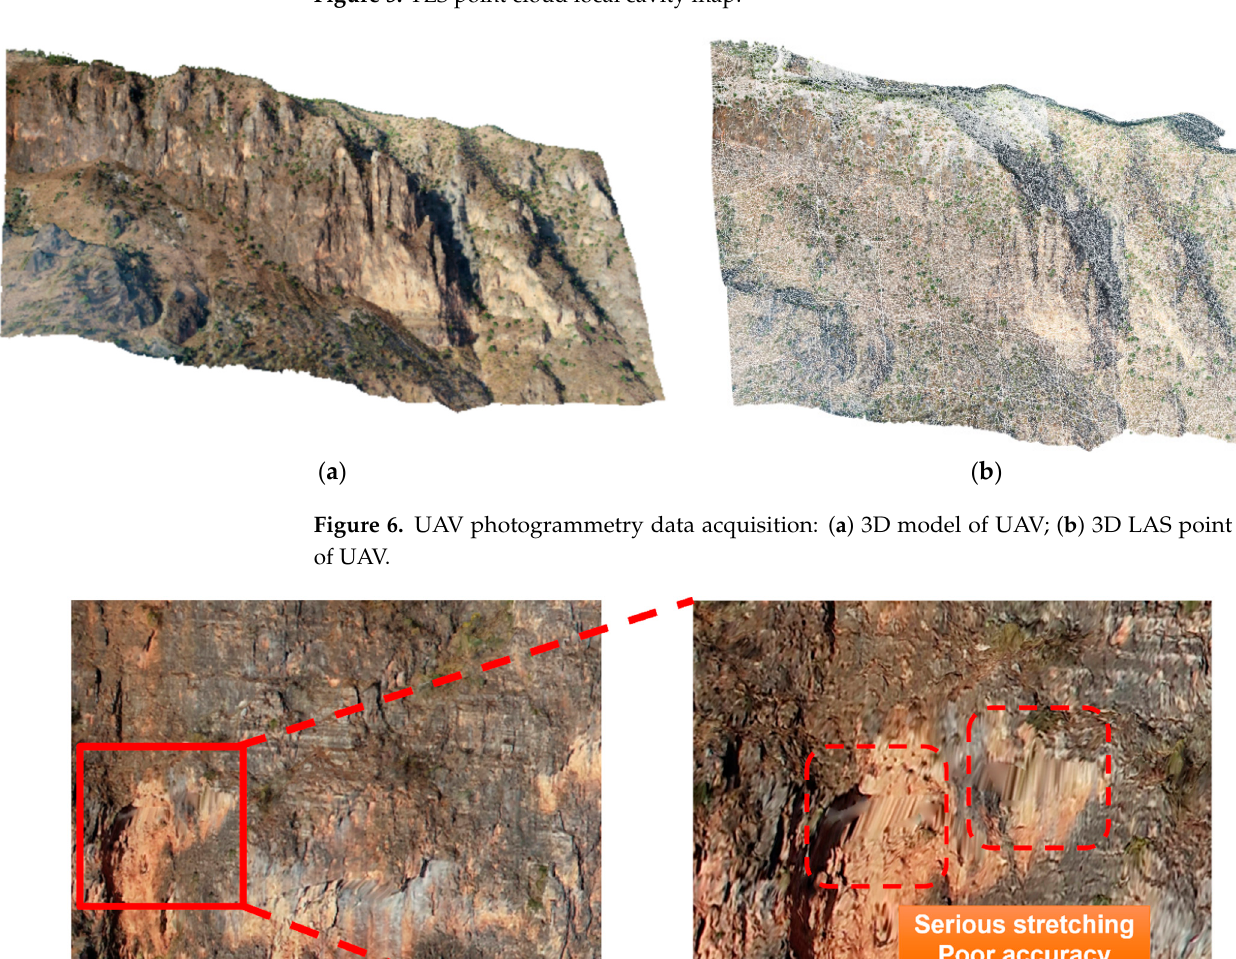
Figure 5. TLS point cloud local cavity map.